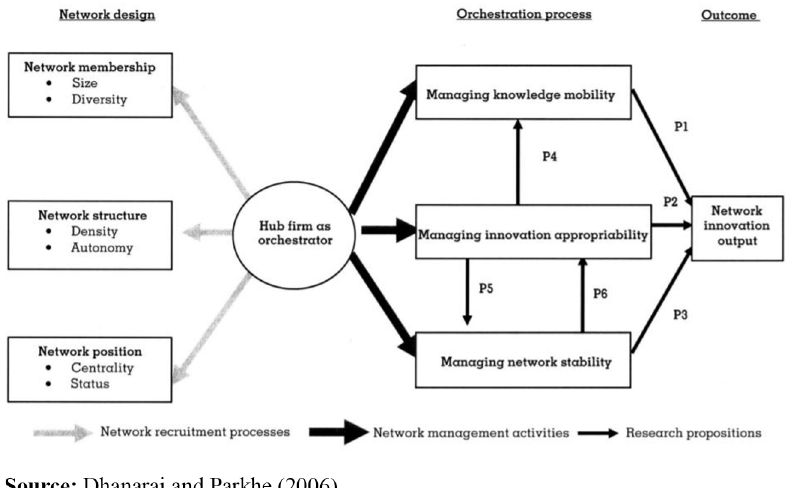
Figure 1. Framework for orchestration in innovation